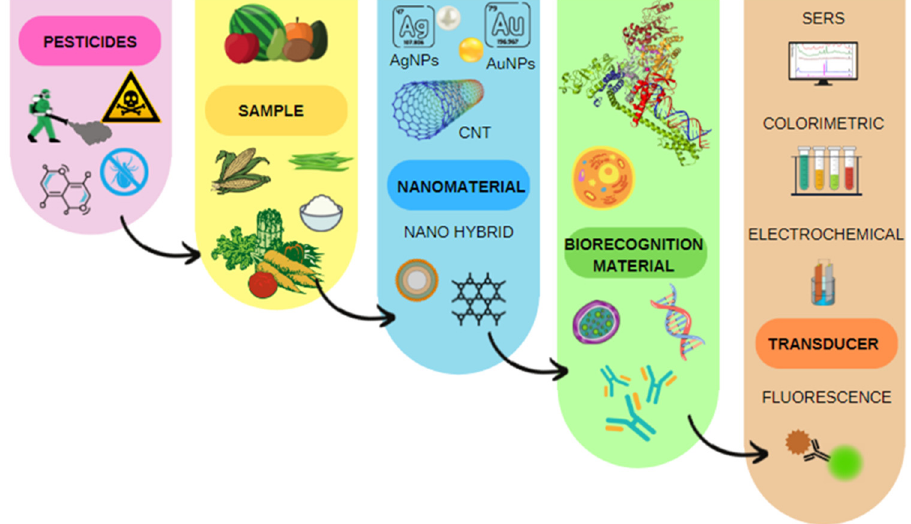
Figure 2. Schematic of the steps that are necessary to build a biosensor.